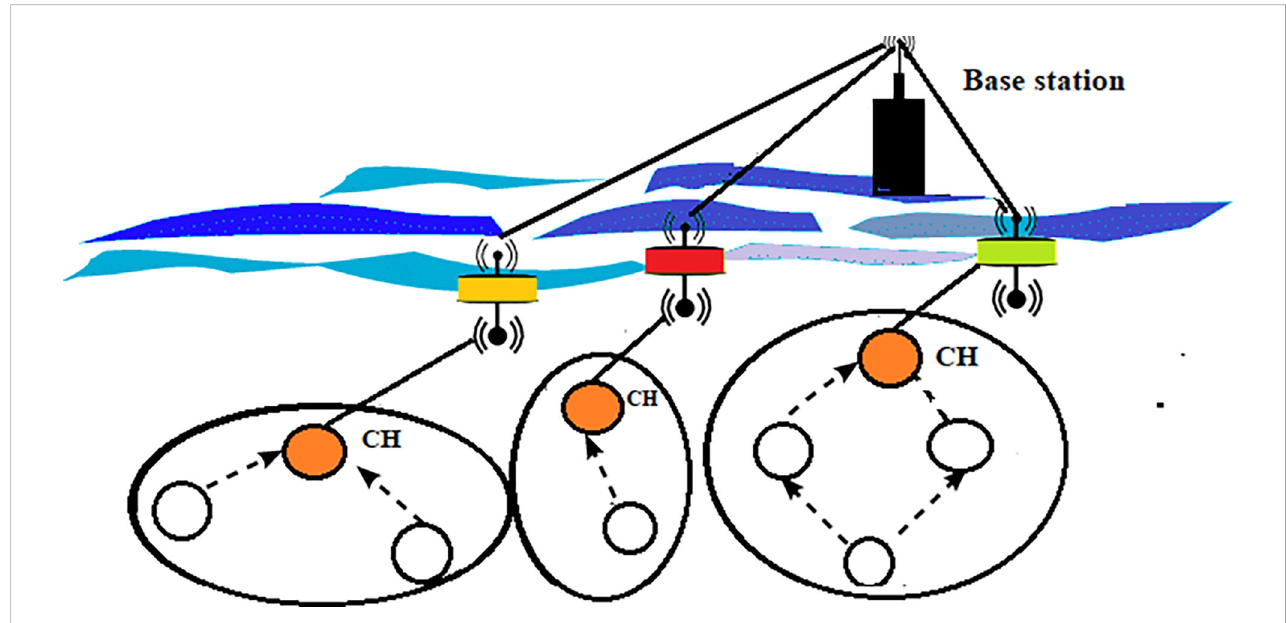
FIGURE 2 UWSN Clustering